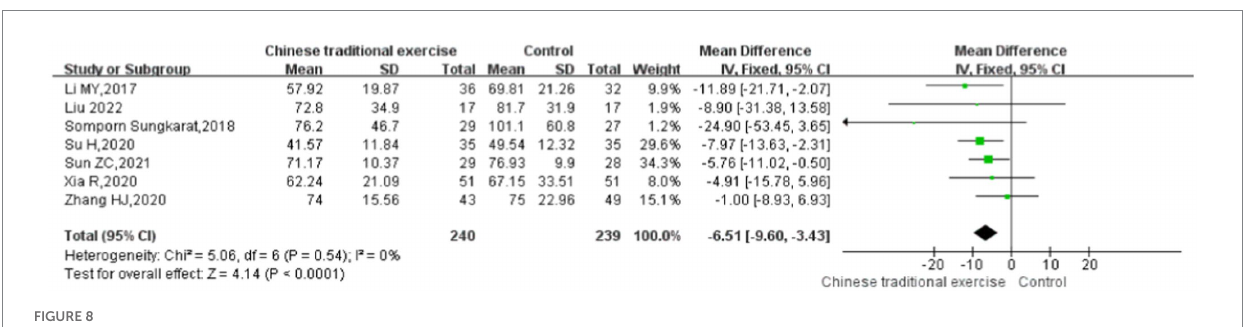
FIGURE 8 Auditory verbal learning test after traditional Chinese